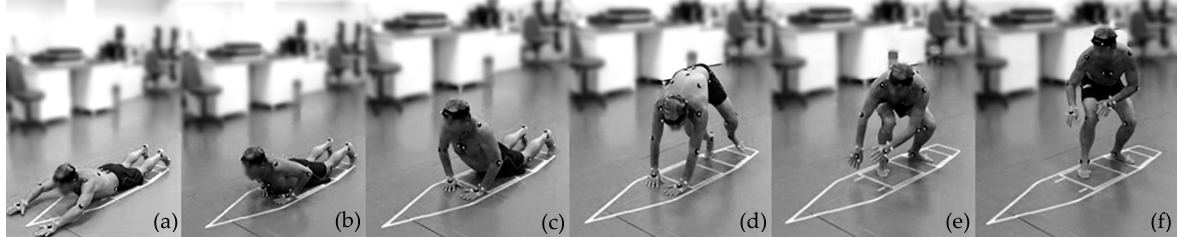
Figure 2. The sequence of movements performed: ( a ) paddle simulation, ( b ) touching hands on the surfboard, ( c ) pushing, ( d ) transition, ( e ) reaching the surfboard, and ( f ) weight stabilization.